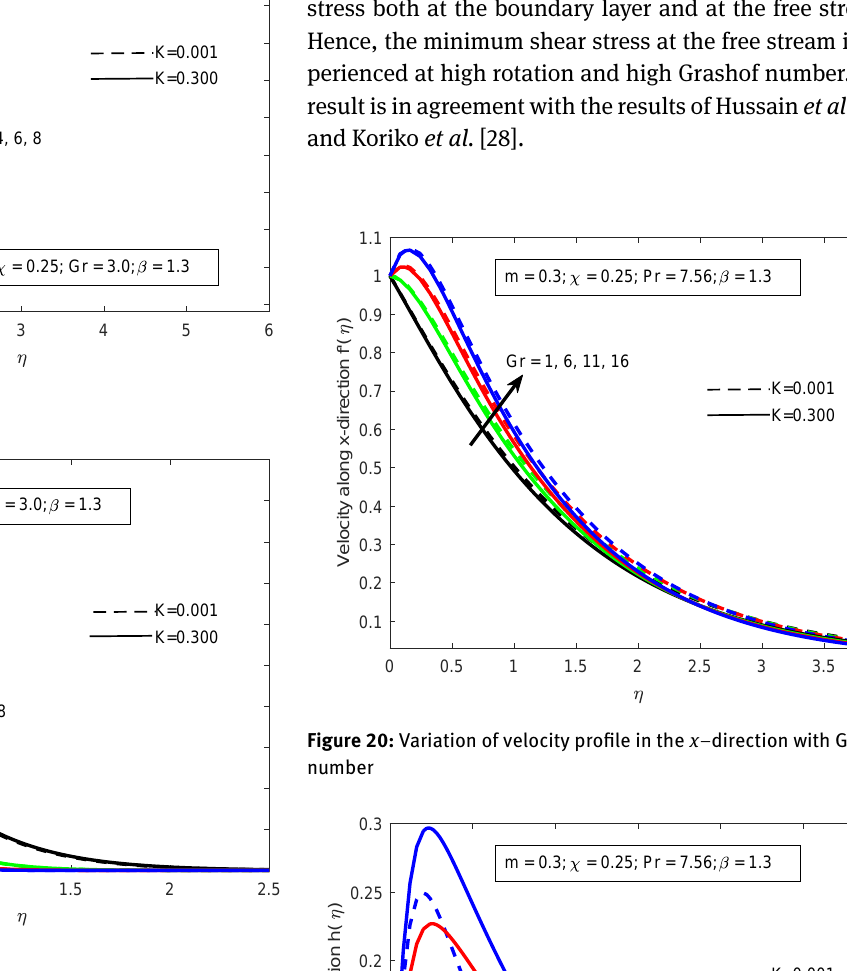
Figure 19: Variation in Θ ( η ) with P r